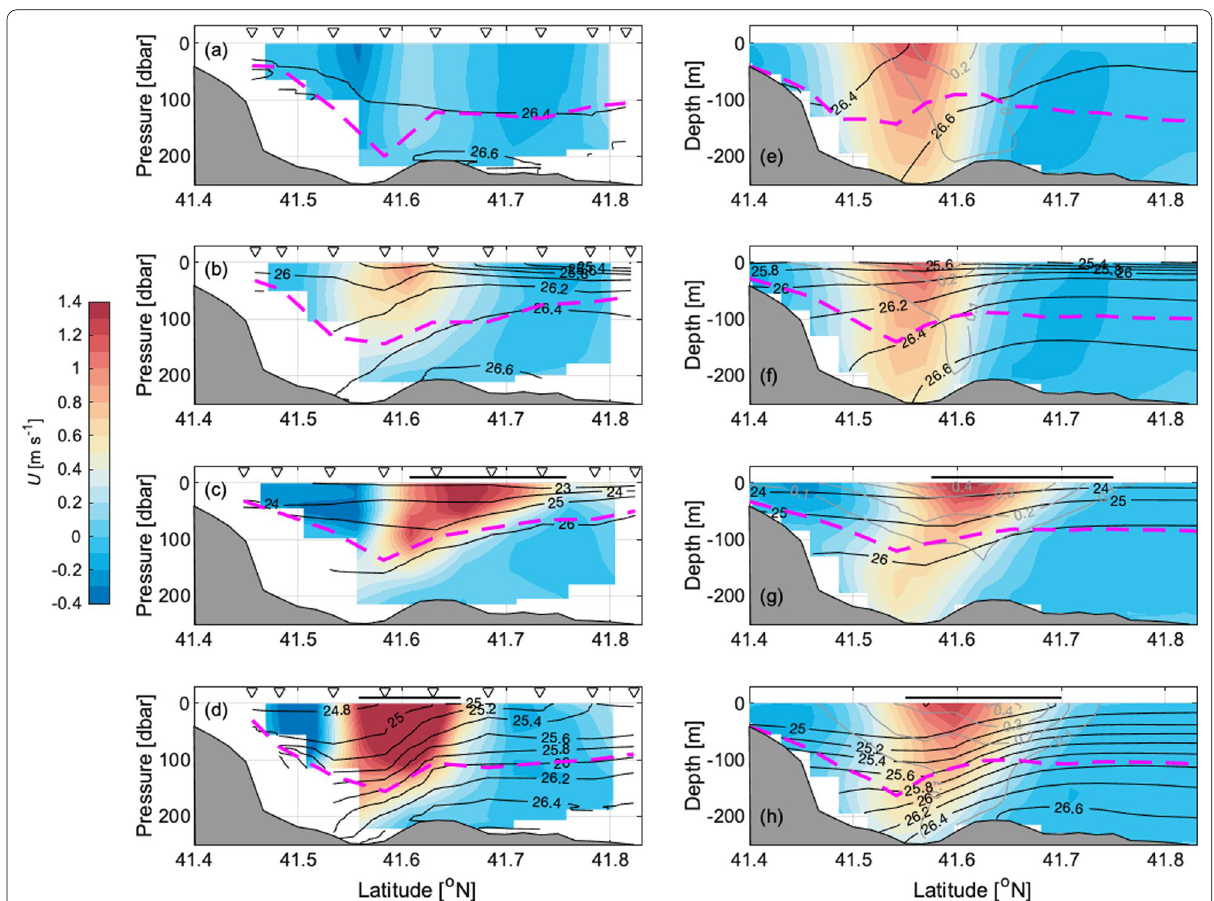
Fig. 3 Vertical transect of seasonal mean geostrophic velocity (zonal velocity) along the Shiriya–Esan line calculated from shipboard observations (141.3°E obtained from JCOPE-T DA data) in a ( e ) winter, b ( f ) spring, c ( g ) summer, and d ( h ) autumn. Black contours denote the potential density anomaly, σ θ . Eastward is positive. The dashed magenta line denotes the depth of the upper layer, H 1 . Black bars in c , d , g , and h indicate the mean range of latitude for the upper- and lower-layer velocities, U 1 and U 2 , respectively. The bathymetry is along 141.3°E. Gray contours in e – h denote eddy kinetic energy [m 2 s − 2